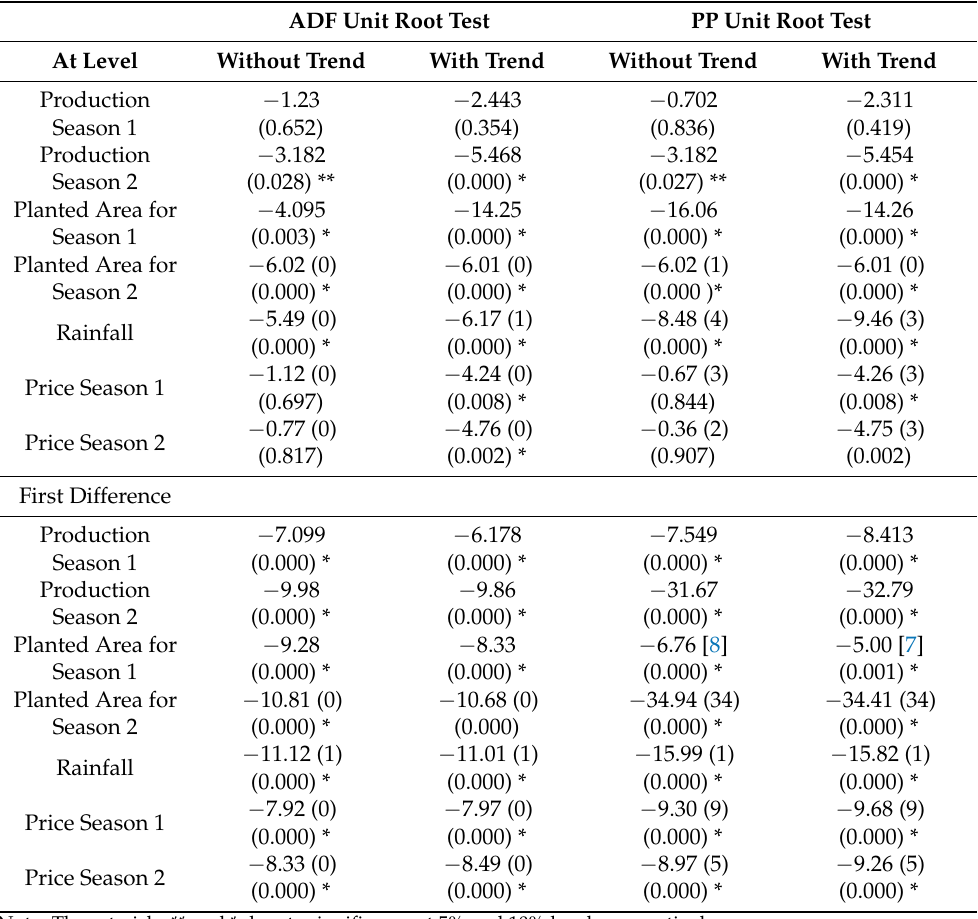
Table 4. Unit root test for selected variables.